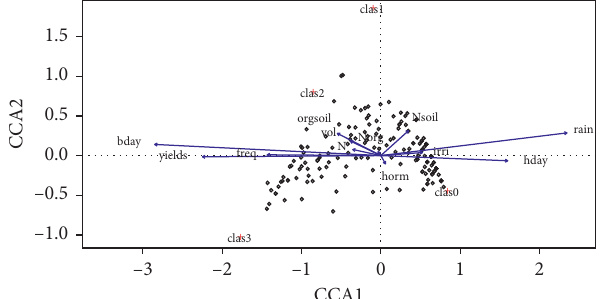
Figure 2: Canonical correlation analysis (CCA) of superficial scald classes of “Abate Fetel” pears (clas0 0%, clas1 1%–25%, clas2 26–50%, and clas3 51–100% of peel symptoms) against quantitative orchard features (blue vectors) and the scores of producers (black circles) in two seasons (2018-2019 and 2019-2020). Total variability explained (23%): CCA1 (95%); CCA2 (3%). The following abbreviations have been used: date of harvest (hday), full bloom date (bday), millimetres of rain (rain) and irrigation (irri) during the growing season, frequency of watering in days (freq), total (N) and organic nitrogen (Norg) expressed in kilograms in fertilizers, nitrogen in soil in percentage (Nsoil), organic matter in soil in percentage (orgsoil), volume of the canopy in m 3 (vol), yields of the orchards in tons (yields), and quantity in grams of gibberellins (horm).